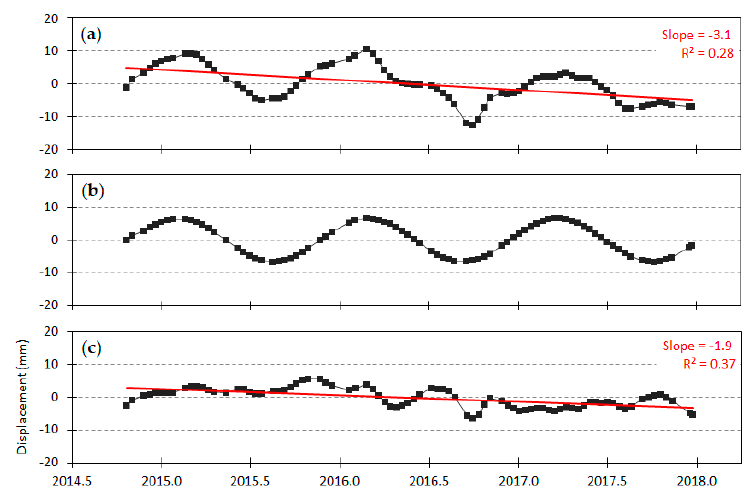
Figure 5. ( a ) Time series of LOS displacements at a selected point (see Figure 4); ( b ) Seasonal component obtained by Fourier transform; ( c ) Time series corrected for the seasonal oscillations.